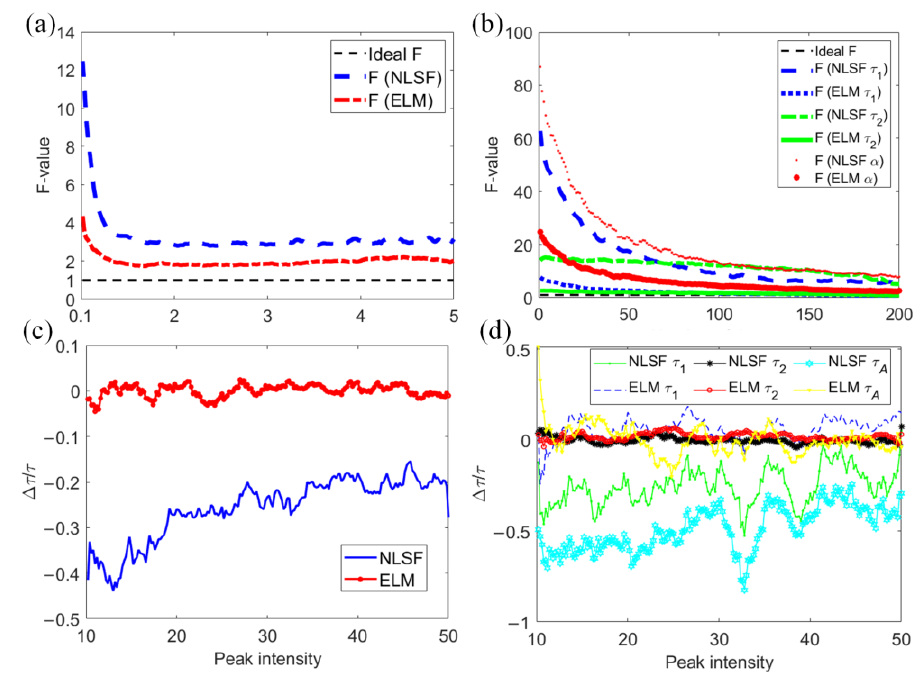
Figure 4. ( a ) F -value for mono-exponential decays with a range [0.1, 5] ns. ( b ) F -values for bi-exponential decays with τ 1 , τ 2 , and α in the ranges [0.1, 1] ns, [1, 3] ns, and [0, 1], respectively. ( c , d ) Bias per histogram for mono- and bi-exponential decays, respectively.